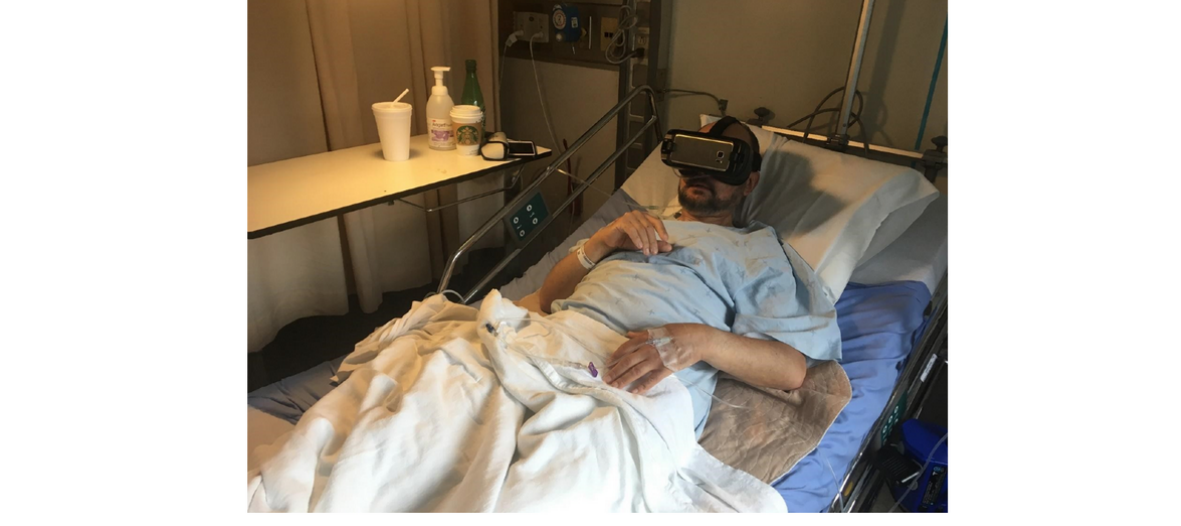
Participants used a Samsung Gear VR HMD and